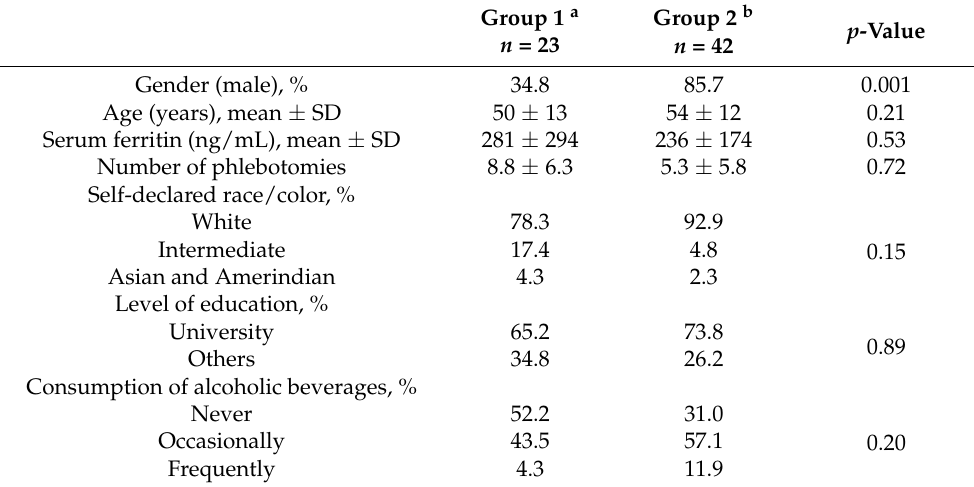
a Group 1: 23 patients with primary iron overload and homozygosity for the p.Cys282Tyr mutation. b Group 2: 42 patients with primary iron overload and other genotypes: compound heterozygosity for the p.Cys282Tyr/p.His63Asp ( n = 10), heterozygosity for the p.Cys282Tyr ( n = 4), homozygosity ( n = 10) or heterozy- gosity ( n = 8) for the p.His63Asp, or absence of p.Cys282Tyr and p.His63Asp ( n = 10).